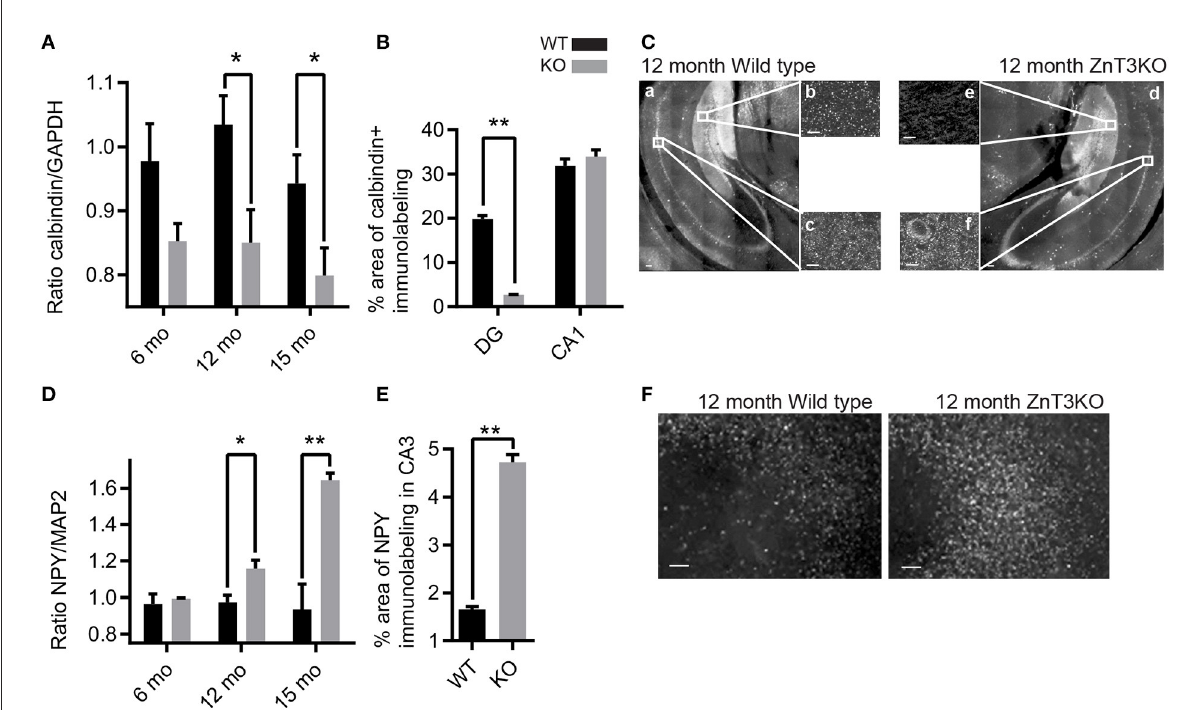
FIGURE5 ZnT3KO hippocampus exhibit age-dependent alterations in calbindin and NPY expression that are consistent with alterations resulting from epileptiform activity. (A) Western blot analysis of hippocampal tissue shows an age-dependent decrease of calbindin protein levels in ZnT3KO mice. (B) Quantification of calbindin immunolabeling shows reduced calbindin in the dentate gyrus, but not in the CA1, region of ZnT3KO hippocampus. (C) Representative images of 12-month-old ZnT3KO and WT mice quantified in (B) . (D) Dot blot analysis of hippocampal tissue shows an age-dependent increase in NPY protein levels in ZnT3KO mice. (E) Quantification of NPY immunolabeling shows NPY expression is increased in the CA3 region of ZnT3KO hippocampus. (F) Representative images of 12-month old ZnT3KO and WT hippocampus quantified in (E) . WT, wild type; KO, ZnT3KO; calbindin immunoblots, 3 and 6 mos. n = 5, 12 mo. n = 8, 15 mo. n = 7; NPY dot blots, 3 and 15 mos. n = 4, 6 mo. n = 3, 12 mo. n = 5; scale bars a and d, 100 µ m; b, c, e, and f, 10 µ m; * p < 0.05, ** p < 0.001; two fields from each subject was imaged at 63x magnification, quantified using the Axiovision (Zeiss) automated measurement program and the percent area calculated. Immunoblot values expressed as normalized densitometry relative to GAPDH or MAP2. Data were analyzed by two-tailed unpaired t -test. Error bars indicate the mean ±